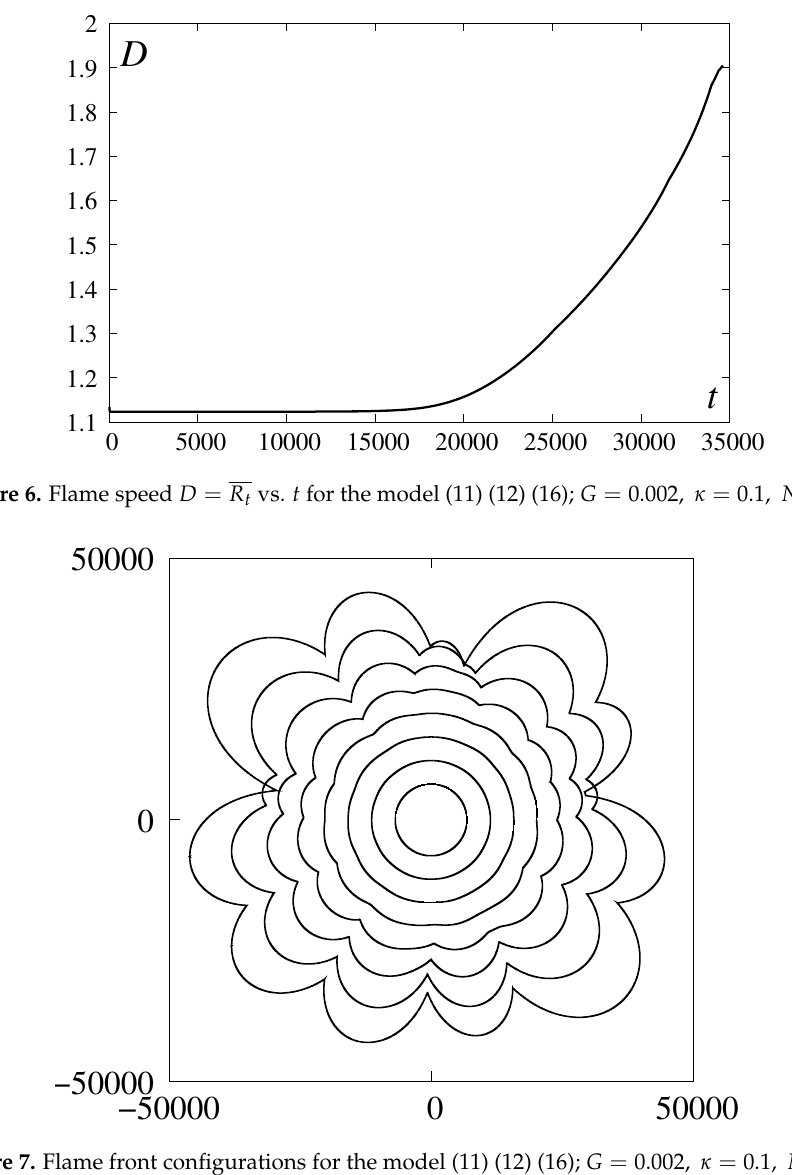
Figure 7. Flame front configurations for the model (11) (12) (16); G = 0.002, κ = 0.1, N = 2 15 . Occurrence of the inverse cascade is most graphically manifested in the channel